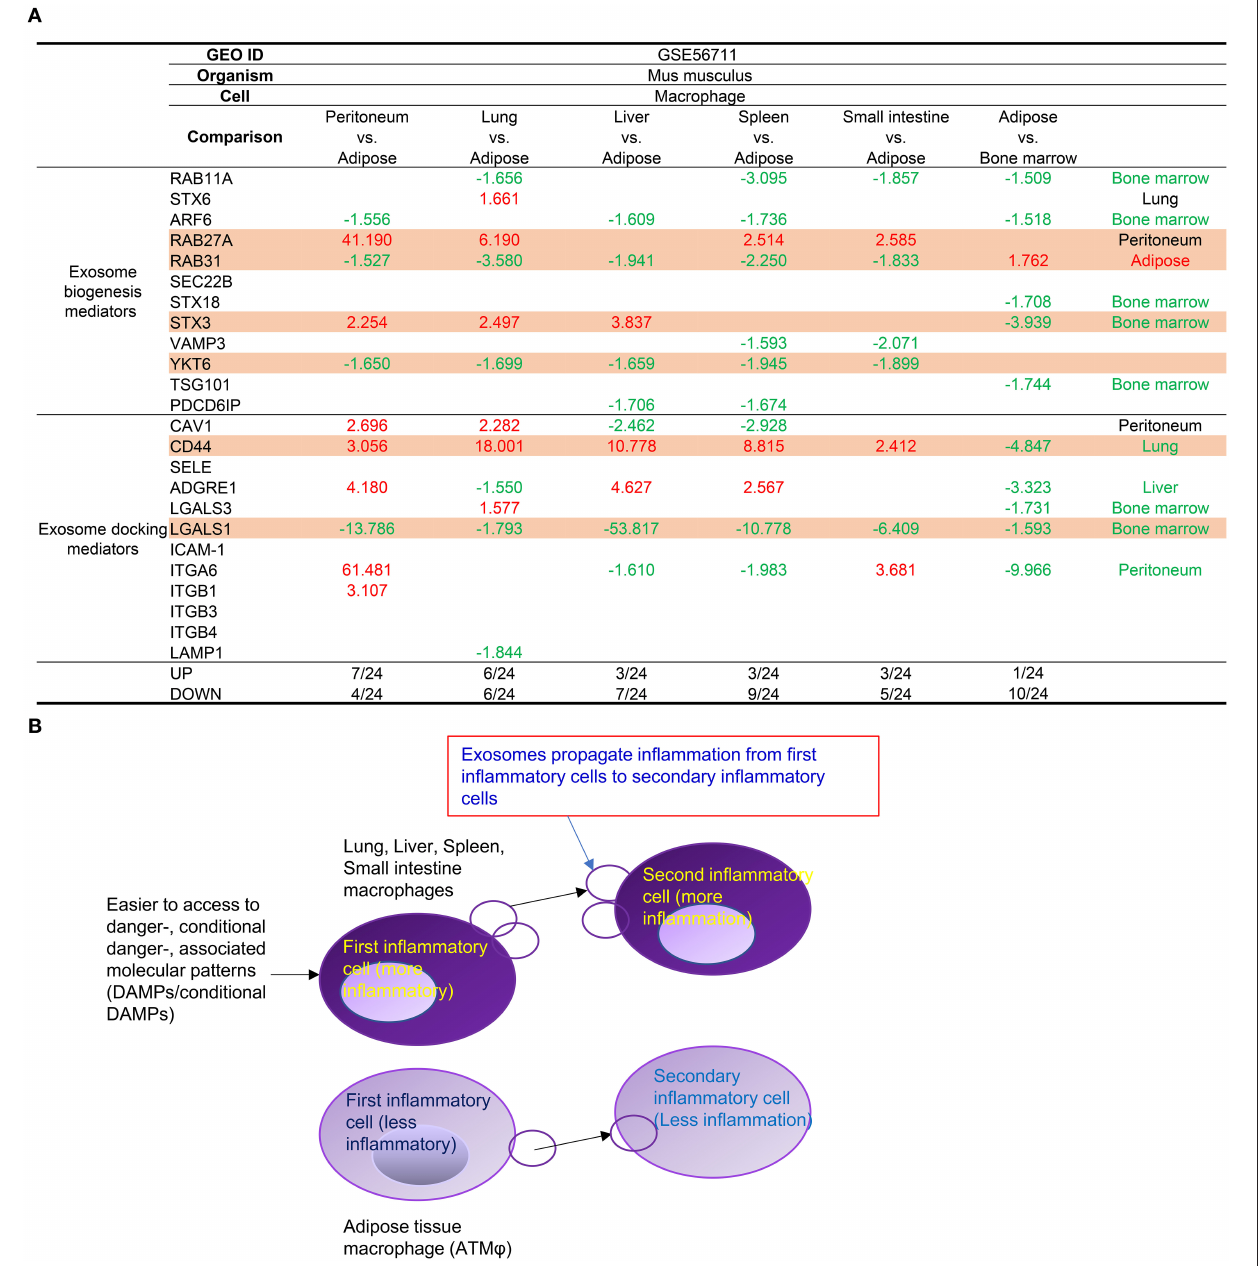
(innate immune memory) functions in the form of increases in three key metabolic pathways: glycolysis, acetyl-CoA synthesis, and the mevalonate pathway (65). Thus, in addition to